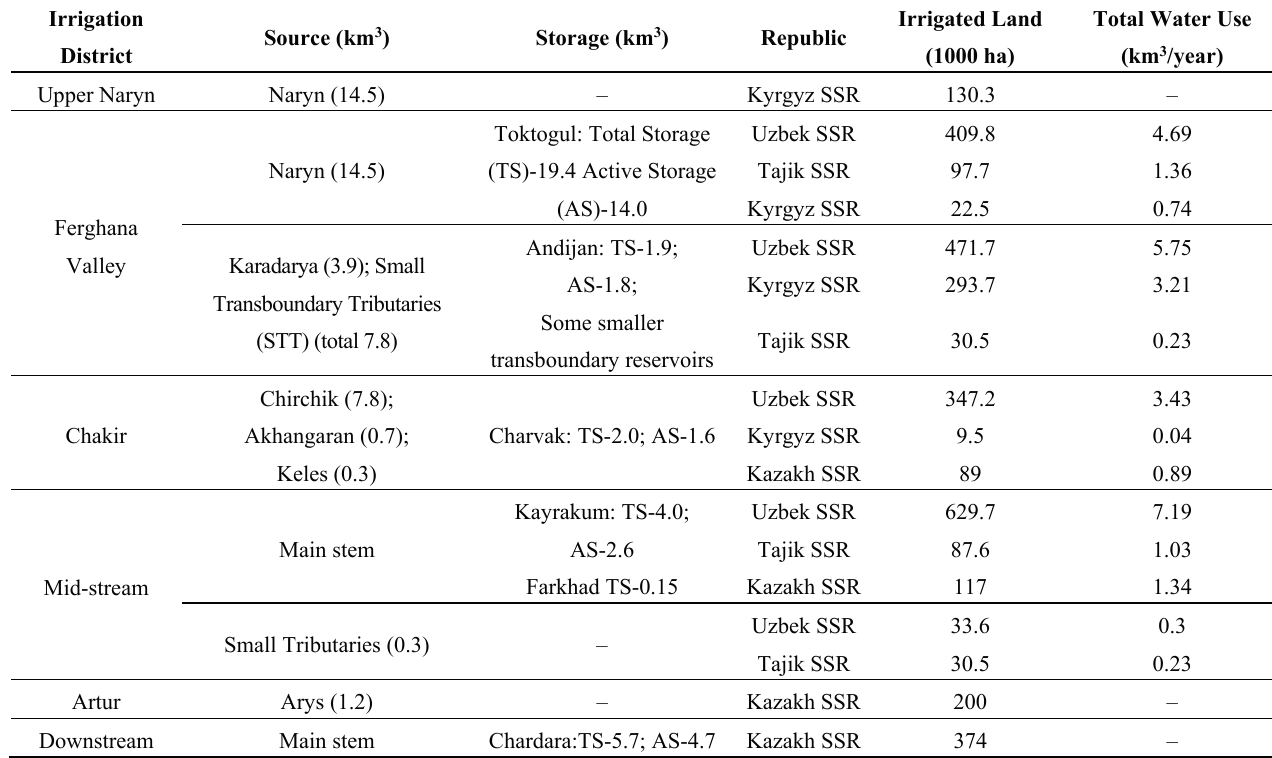
Table 1. Features of irrigation districts (Source: adapted from